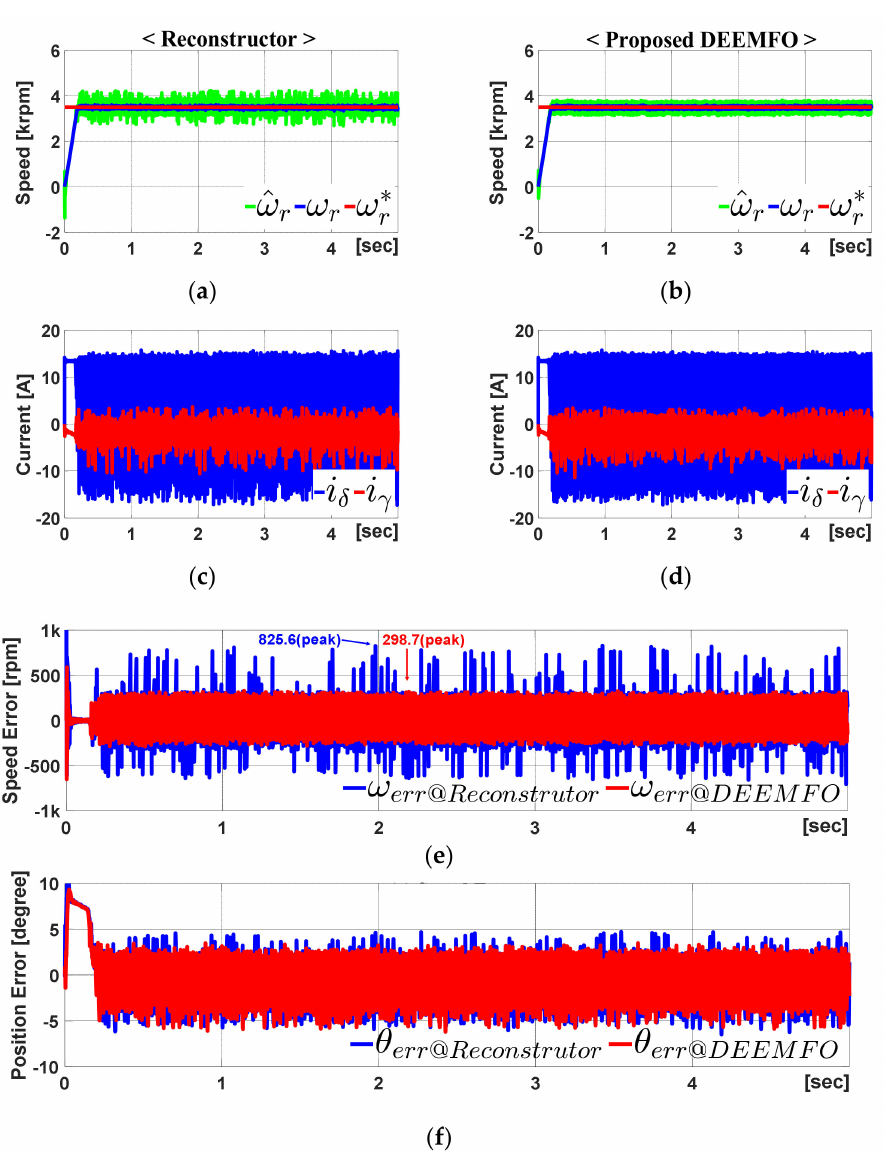
Figure 10. Simulation results under the condition that the parameter changed by 30%. ( a ) reference, real, and estimated speed with reconstructor; ( b ) reference, real, and estimated speed with DEEMFO; ( c ) γ − δ axis currents with reconstructor; ( d ) γ − δ axis currents with DEEMFO; ( e ) comparison of speed errors in reconstructor and DEEMFO; ( f ) comparison of position errors in reconstructor and